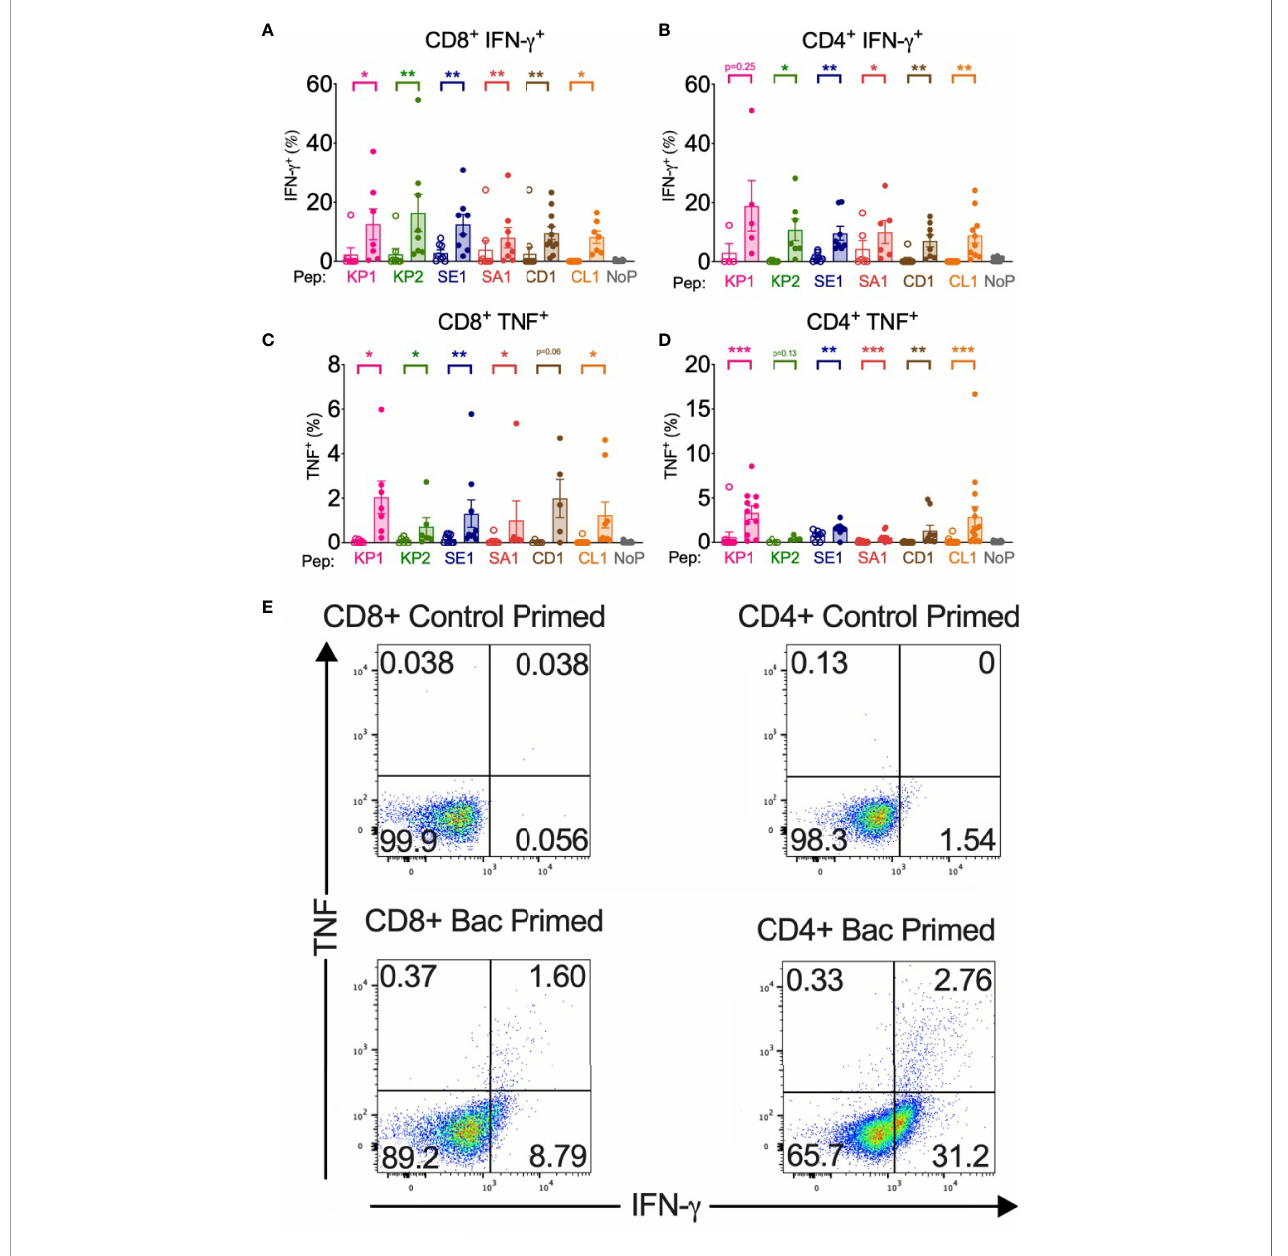
FIGURE 2 | Bacterial peptide priming enhances SARS-CoV-2 T cell cytokine expression in responders. Pathogenic bacterial peptide (bac) primed T cells restimulated with SARS-CoV-2-peptide measured by fl ow cytometry with background control values subtracted. Unshaded bars- Control primed (irrelevant peptide, PVSKMRMATPLLMQA), then restimulated with SARS-CoV-2 homologous peptide. Shaded bars – bac primed (KP1, KP2, SE1, SA1, CD1 or CL1) then SARS-CoV- 2-peptide homologue restimulated. NoP – no peptide negative control. (A) CD8+ IFN- g + responses ( n =7-12), (B) CD4 + IFN- g + responses ( n =5-10), (C) CD8 + TNF + responses ( n =5-9), (D) CD4 + TNF + responses ( n =4-15), (E) Representative TNF (y-axis) and IFN- g (x-axis) dot plots of a responder donor with their corresponding SARS-CoV-2 primary response control. * P <0.05, ** P <0.01, *** P <0.001 by Wilcoxon-matched-pairs-signed-rank test, comparing magnitude of response to SARS- CoV-2 peptides with or without bacterial peptide